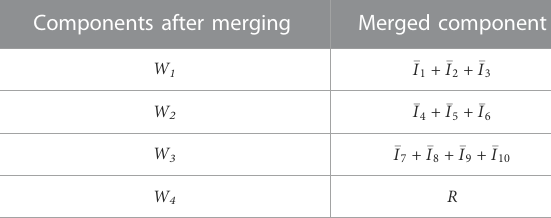
TABLE 2 CEEMDAN IMF component merger results. Components after